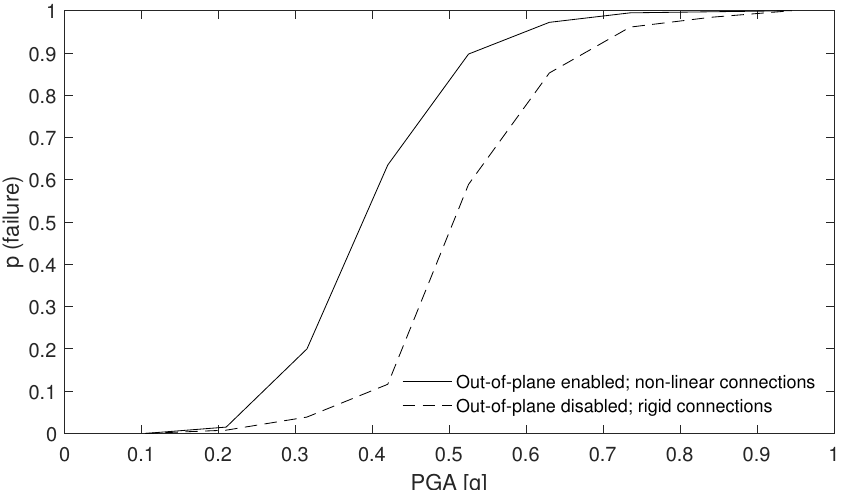
Figure 25. Comparison of Holsteiner Hof fragility curves for models with: (i) out-of-plane enabled and non-linear connections, and (ii) out-of-plane disabled and rigid